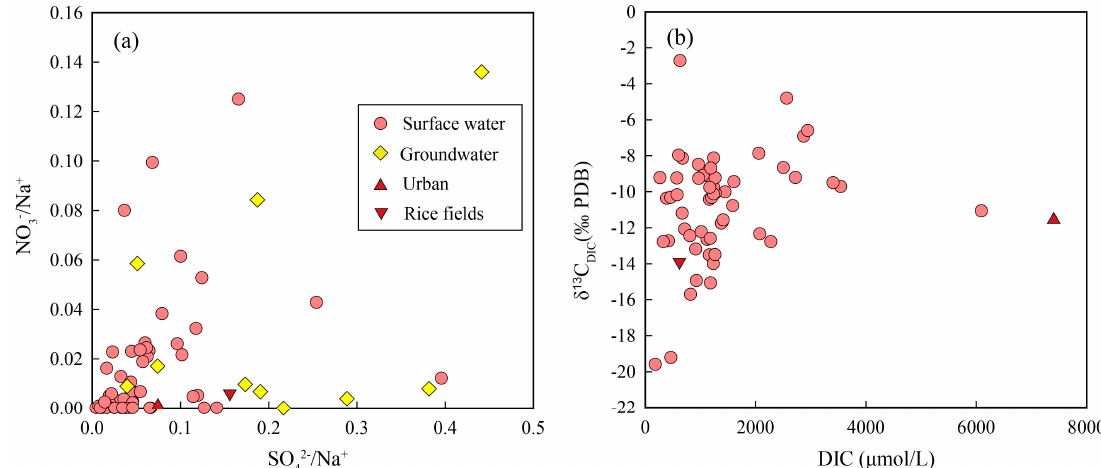
− / Na + vs. SO 42 − / Na + ( a ) and δ 13 C Figure 6. Plots of NO 3 − /Na + vs. SO 42 − /Na + ( a ) and δ 13 C DIC vs. DIC ( b ). Figure 6. Plots of NO 3